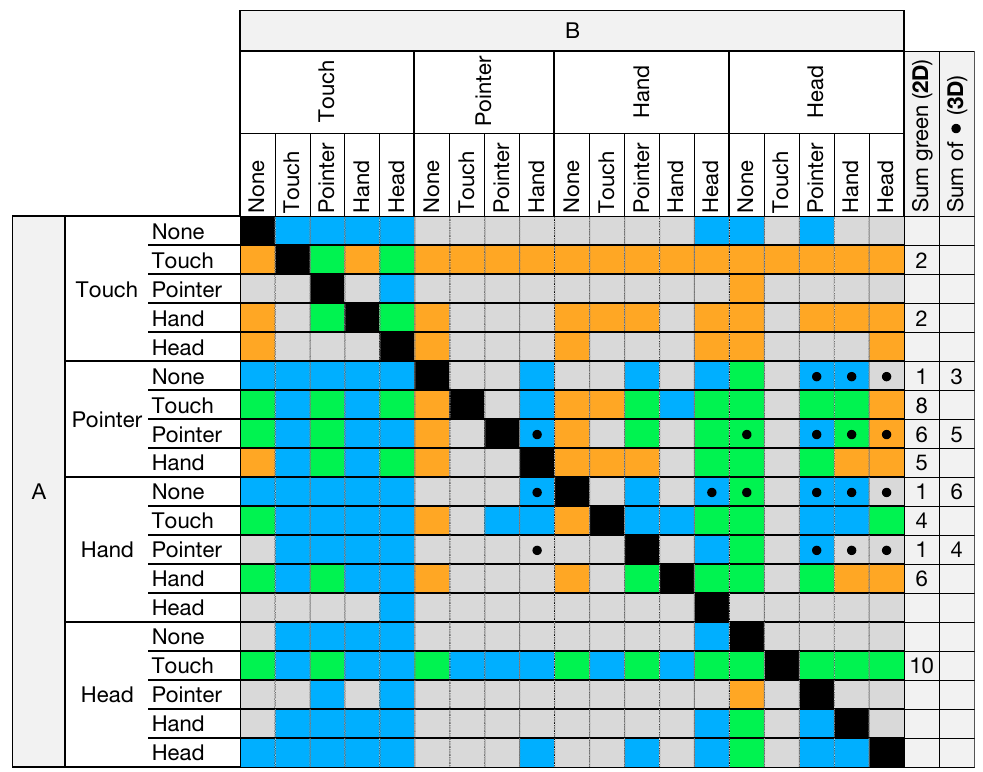
Figure 6. Matrix showing all significant ( p < 0.05) interactions between the 19 tested 2D techniques. Technique x from row A is (blue = faster|orange = more accurate|green = faster and more accurate) than technique in y from column B. Matrix also shows all significant ( p < 0.05) interactions between the 11 tested 3D techniques in terms of time, represented as black dots ( • =